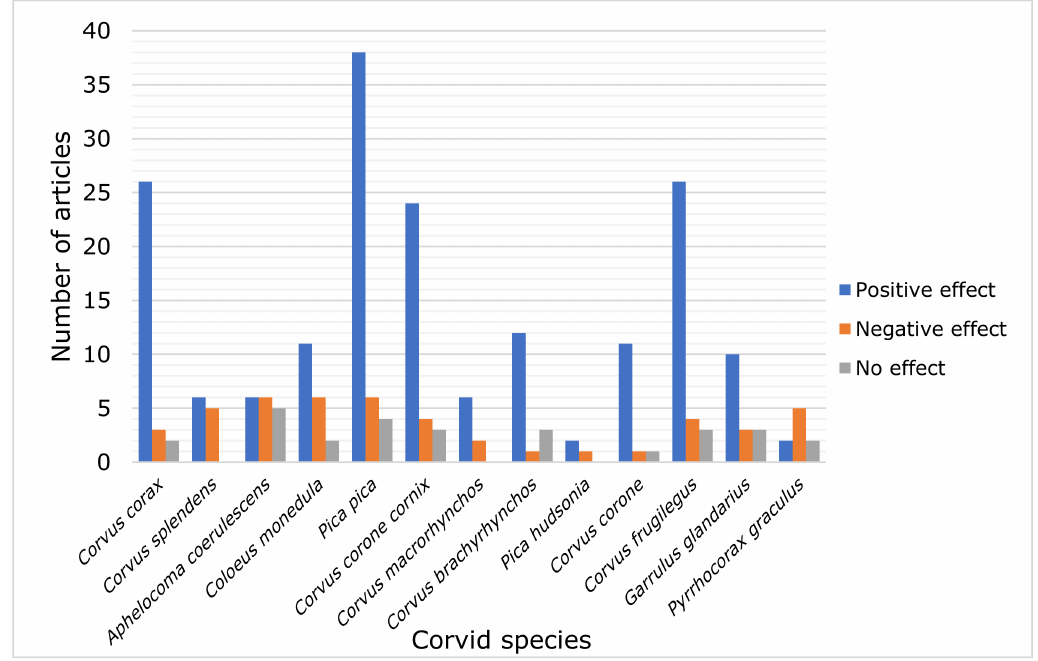
Figure 2. Number of articles reporting positive, negative or no effect of urbanization on the most frequently studied corvid species ( n =